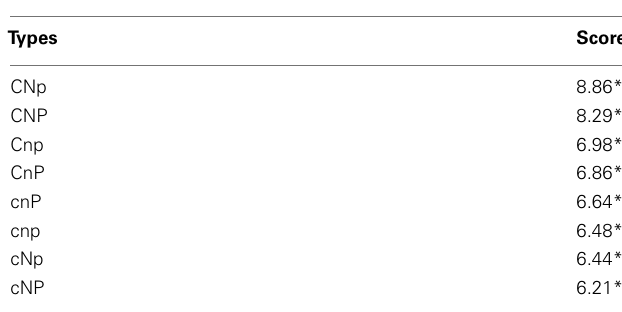
Table 1 | Ranking of spatial autocorrelation between pairs of the same genotype with average z -score.